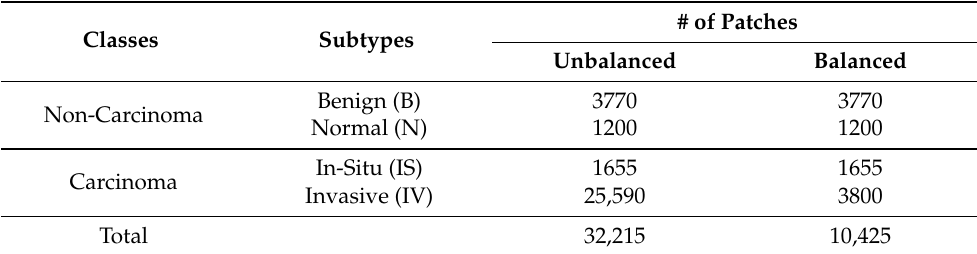
Table 2. Structure of the ICIAR2018 with 20 × magnification factor.